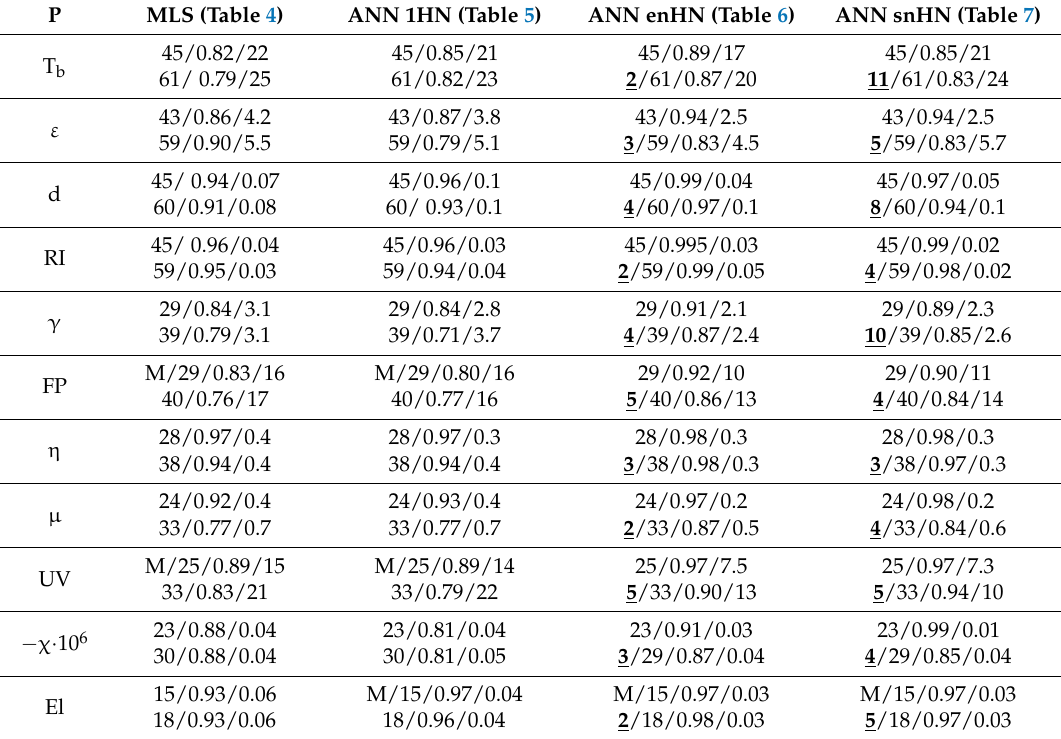
Table 9. Statistical, N/r 2 (2nd decimal figure)/s, results for the eleven properties from Tables 4–7. 2nd column: MLS, results, 3rd column: ANN with one hidden neuron (ANN 1HN) results, 4th column: ANN with externally chosen number of hidden neurons (ANN enHN) results, 5th column: ANN with software chosen number of hidden neurons (ANN snHN) results. First line shows the statistical results for the training (MLS) and train plus test (ANN) compounds, the second line shows the overall statistical results inclusive of the evaluated compounds. M stands for MMCIs (otherwise they are MCIs). The last two columns show also the number of hidden neurons (second line, underlined and